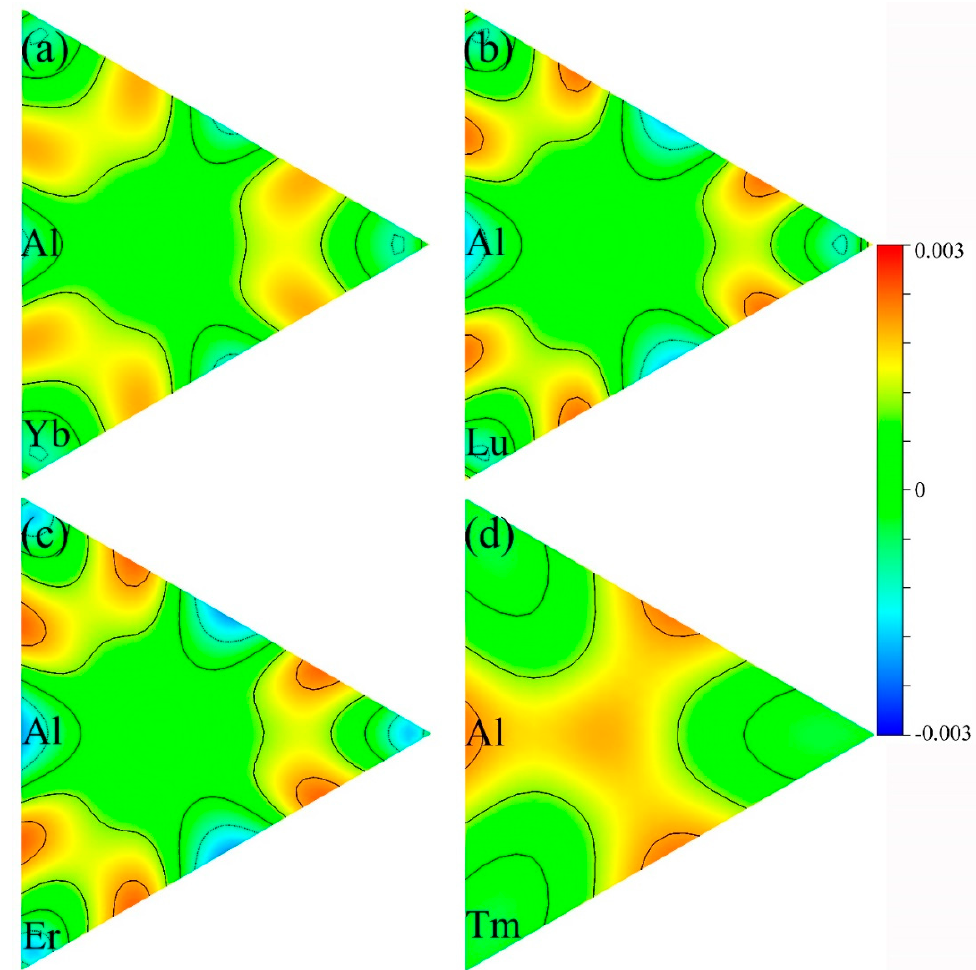
Figure 7. Charge density distribution of the L1 2 -Al 3 M phase in (111) plane: ( a ) Al 3 Yb, ( b ) Al 3 Lu, ( c ) Al 3 Er, and ( d ) Al 3 Tm. All the contour plots have the same scale, and the interval between the contour lines is 0.001e/bohr 3 .